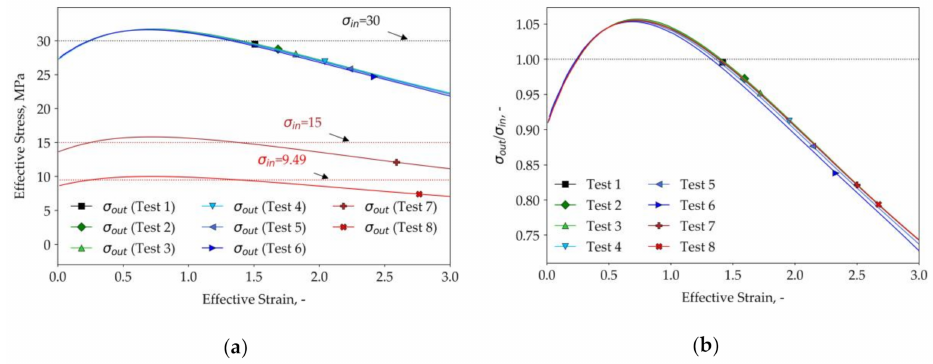
Figure 3. The e ff ect of the specimen thickness, friction coe ffi cient, nominal strain rate, and the value of K on the tensile test results for the material described by the Backofen model: ( a ) the output stress–strain curves; ( b ) the normalized output stress ( σ out / σ in ) vs. strain curves.